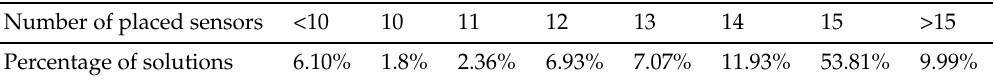
Table 1. Percentage of solutions per number of placed